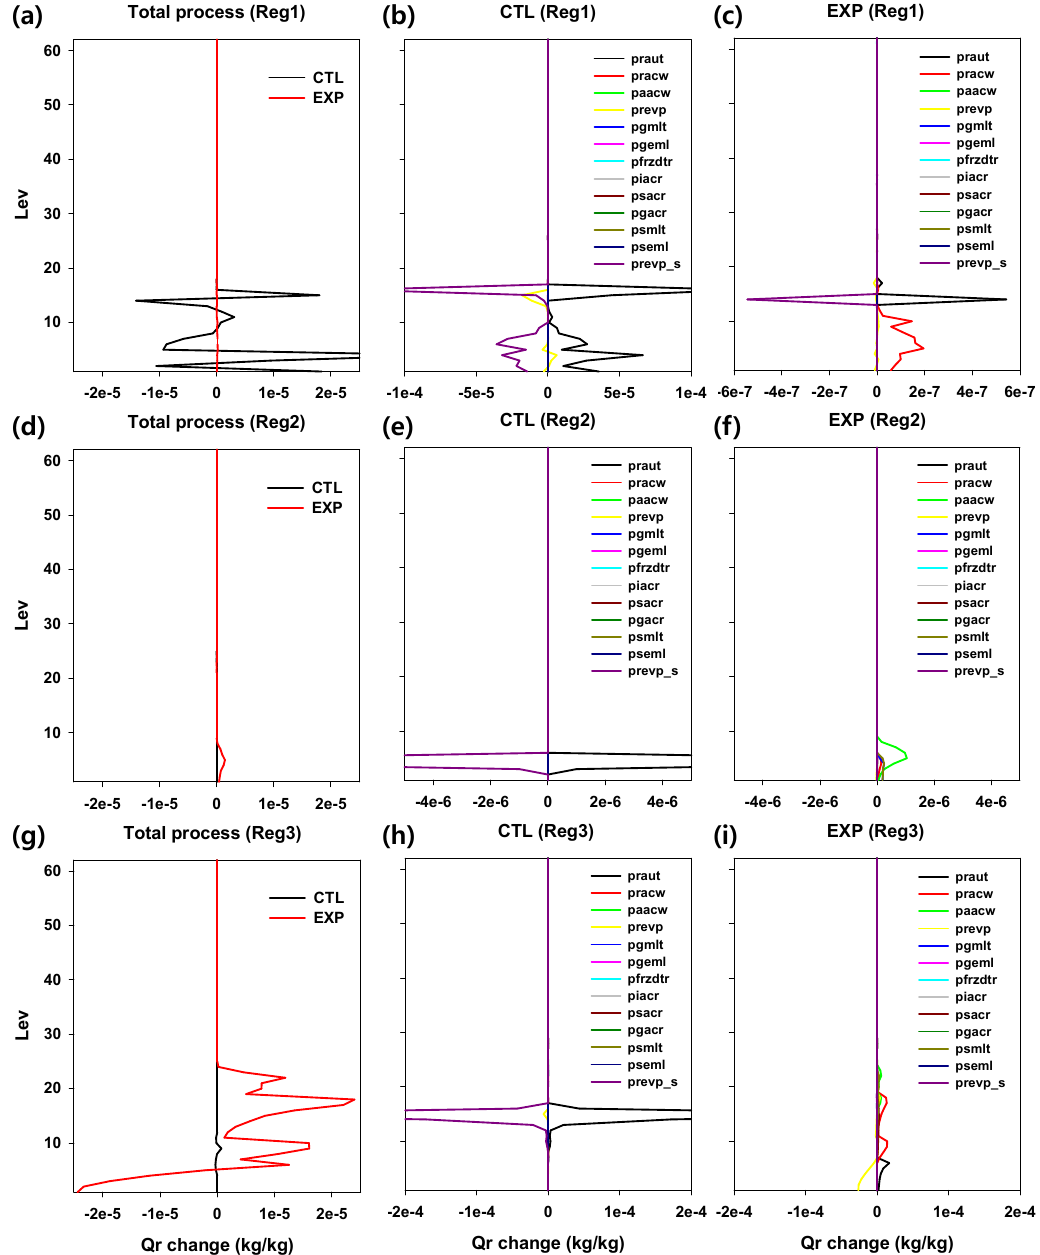
Figure 6. Vertical profiles of rain waters formed or eliminated via the total processes (first panel) and each source/sink process of MPS in CTL (second panel) and EXP (third panel) at one point at a specific time step for regions (a)-(c) 1, (d)-(f) 2, and (g)-(i) 3. The symbols for each process are described in Table A1.